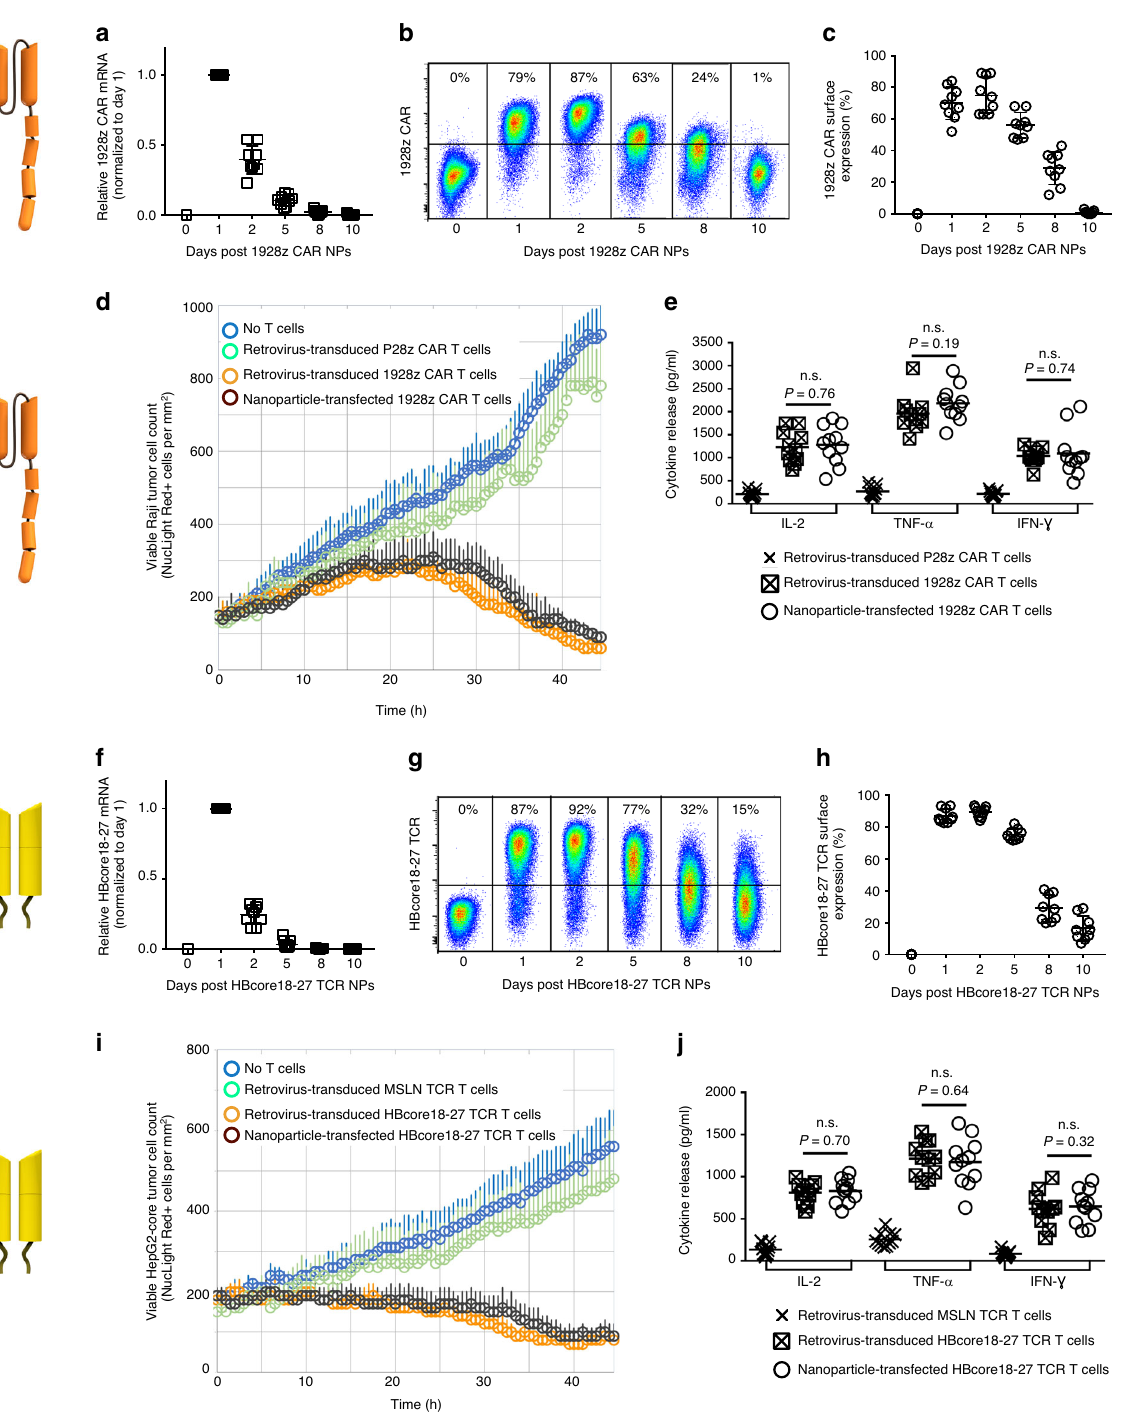
nanoparticles ef fi ciently reprogrammed circulating T cells to recognize leukemia cells (mean 10% CAR + among CD8 + ± 4.3%, Fig. 4d, e). As expected with mRNA delivery systems, these CARs were transiently expressed for up to 1 week (0.8 ± 0.4% CAR + CD8 + T cells on day 7). Notably, repeat doses of nanoparticles were as effective as the fi rst injection and achieved an average of 10.7 ± 3.6% gene transfer into host T cells (Fig. 4e). This suggests that, despite its transient nature, IVT mRNA can serve as a platform to achieve persistent in situ CAR expression in host